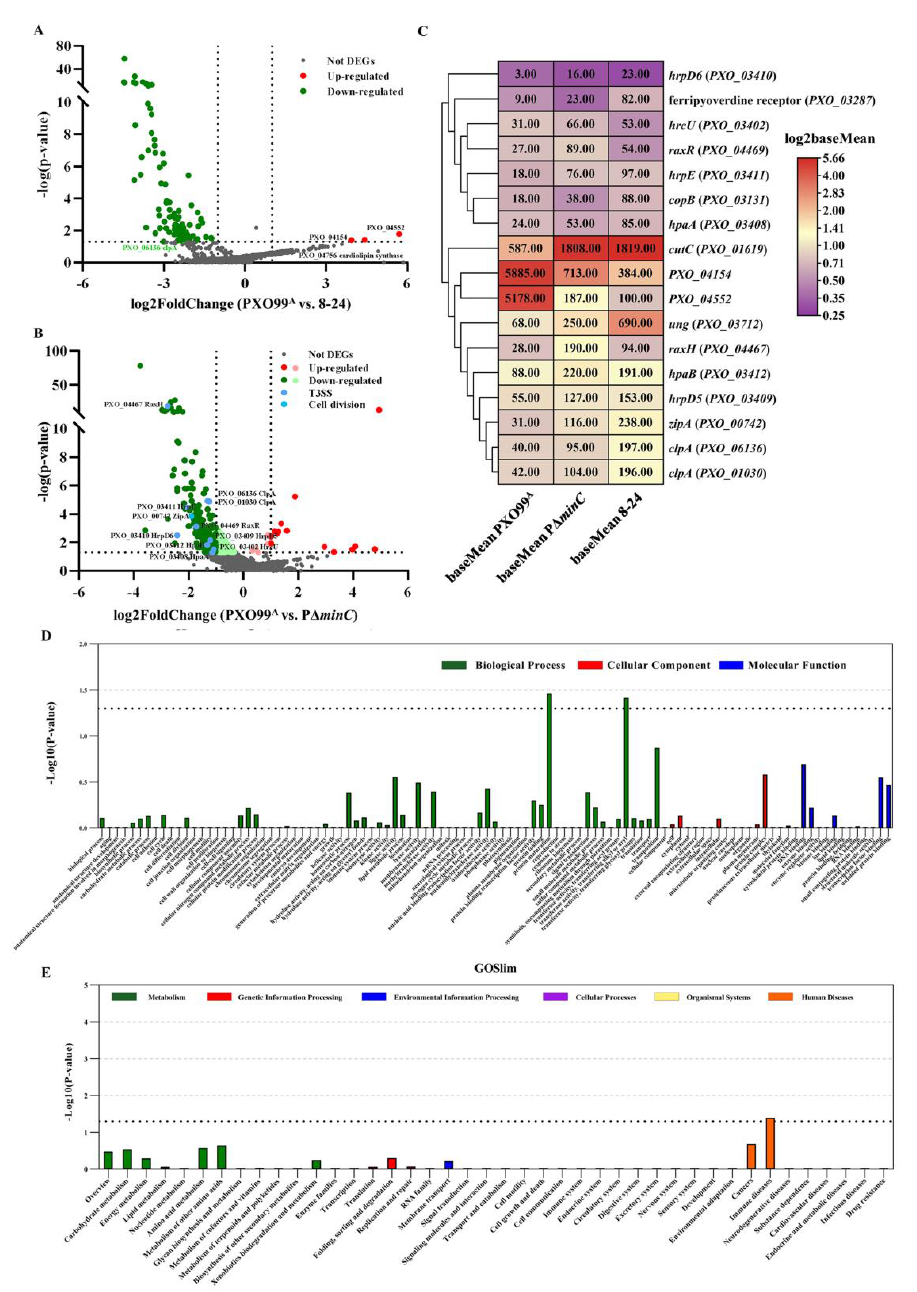
Figure 6. Analysis of the differentially expressed genes (DEGs) in PXO99 A versus in P ∆ minC and 8–24. ( A ) The log 2 Foldchange of DEGs in 8–24 and ( B ) P ∆ minC was plotted against the p -value. Statistically significant differentially expressed genes, with a log 2 Foldchange ≥ 1 or ≤ − 1, are depicted as the red and green dots, respectively, and insignificant as grey dots. For each organism, the shade of the color represents the level of gene expression. Dark blue dots represent T3SS-associated genes. Light blue dots represent cell division-associated genes. ( C ) Heatmap of gene expression of the differentially expressed genes (DEGs) in minC mutants 8–24 and P ∆ minC . The color gradient indicates the normalized base mean values of DEGs (high expression (red) and low expression (purple)). ( D ) GO analysis of DEGs in P ∆ minC mutant. The abscissa axis represents the GO category, and the ordinate axis represents the value of significance ( p < 0.05). ( E ) KEGG analysis of DEGs in P ∆ minC mutant. The abscissa axis represents the KEGG pathway, and the ordinate axis represents the value of significance ( p <